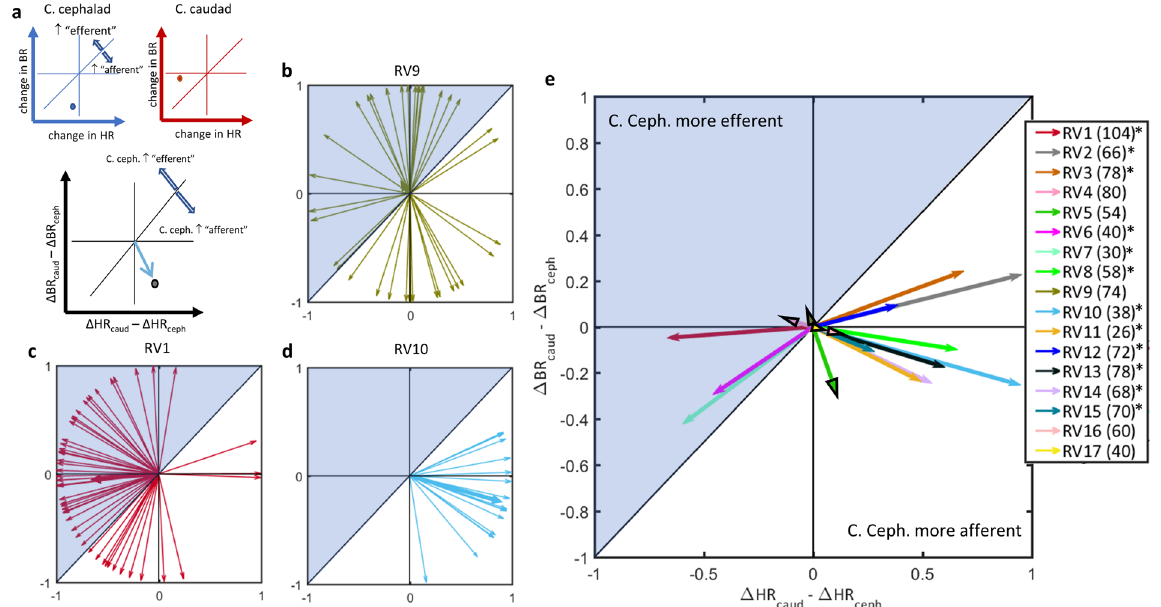
Figure 3. Net vagal responses to trains of stimuli of opposite polarities. ( a ) With cathode cephalad polarity (top left, blue axis), afferent (BR) and efferent (HR) responses are registered, represented as a point in the 2-D plot; horizontal and vertical lines denote zero change in BR and in HR, respectively. Points below unity line represent response patterns that are more afferent than efferent. With cathode caudad polarity (top right, red axis), the point lies above unity line, suggesting a greater efferent effect. By subtracting the afferent and efferent responses associated with each polarity (cathode caudad minus cathode cephalad), a “polarity-difference” vector plot was obtained (bottom panel). Vectors that point downwards the unity line represent stimuli for which the cathode cephalad polarity has an “afferent” net vagal response, and vice-versa for vectors pointing upwards. ( b ) Polarity difference vectors computed from 74 VNS trains in one animal (RV9). Vector directions span the entire angle space, suggesting no overall effect of polarity on the net vagal responses. Consistent with that, the vector sum (thicker vector) is short in length and the distribution of vector directions was uniform (Rayleigh test, p NS). ( c ) Polarity difference vectors in another animal (RV1, 104 VNS trains). The vector sum points upwards the unity line and the distribution of vector directions is not uniform (Rayleigh test, p < 0.01), indicating that cathode cephalad polarity had a significantly “efferent” net vagal response. ( d ) Polarity difference vectors in a third animal (RV10, 38 VNS trains), with vector sum pointing downwards (Rayleigh test, p < 0.01), indicating that cathode cephalad polarity had a significantly “afferent” net vagal response. ( e ) Preferred directions of polarity difference vectors in 17 animals (numbers of VNS trains indicated in the legend). Vector sums with black arrowheads denote animals in which the distribution of vectors was uniform (Rayleigh test p > 0.05). Of the 17 animals, 5 had no polarity difference, 9 had a more “afferent” and 3 had a more “efferent” net vagal response to cathode cephalad polarity (asterisks on legends indicates p < 0.01, Rayleigh